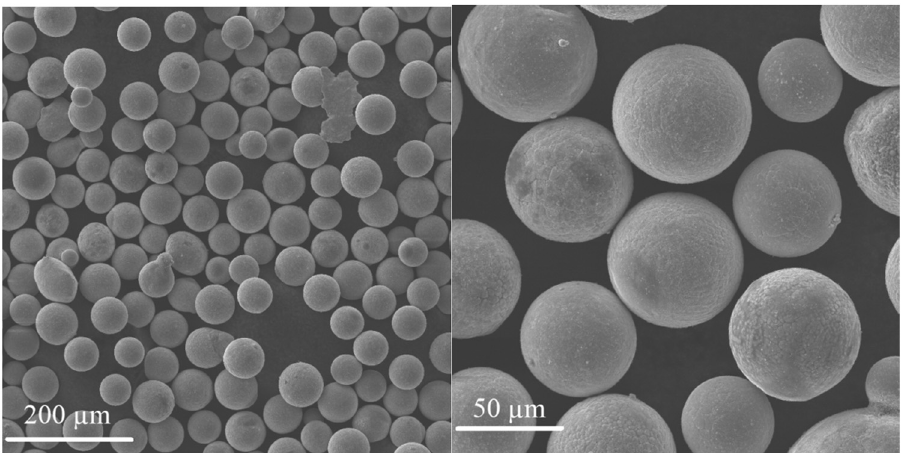
Figure 8: Microphotographs obtained from SEM after sedimentation process.